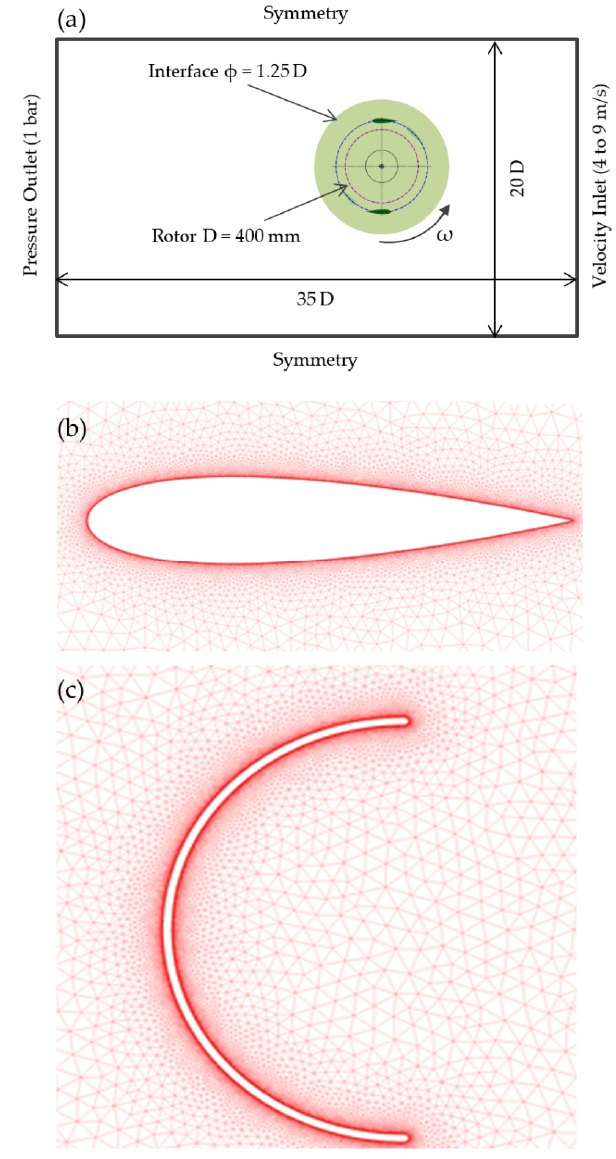
Figure 2. ( a ) Domain Characteristics; ( b ) and ( c ) Mesh near blade walls.